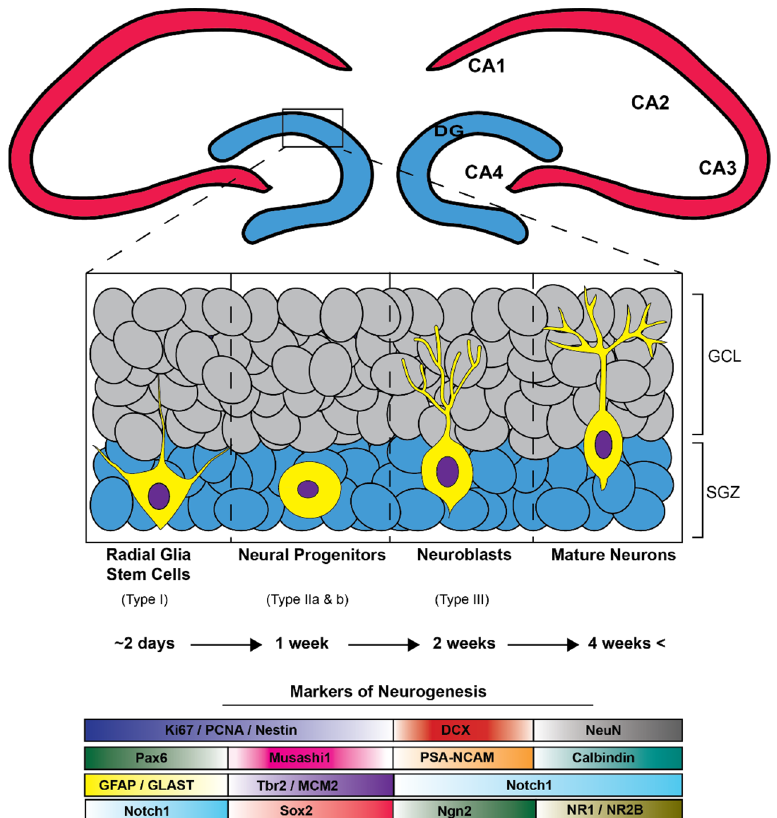
Figure 3. The adult hippocampal neurogenic process is hallmarked by the development and subse- quent maturation of stem cells into granular cell layer neurons (GCL) in the dentate gyrus (DG). Initiation of this functional journey begins with radial-glia-like stem cells in the hippocampal sub- granular zone (SGZ) which differentiate into multipotent progenitors (Type ii a and b) and then into immature neuroblasts/neurons that are subsequentially fated to mature granular cell layer neurons taking approximately four weeks beginning from radial glia-like stem cells and ending with mature GCL neurons. A subset of neurogenesis related immunohistochemical markers that can be utilized to distinguish stages and cell types of adult neurogenesis.